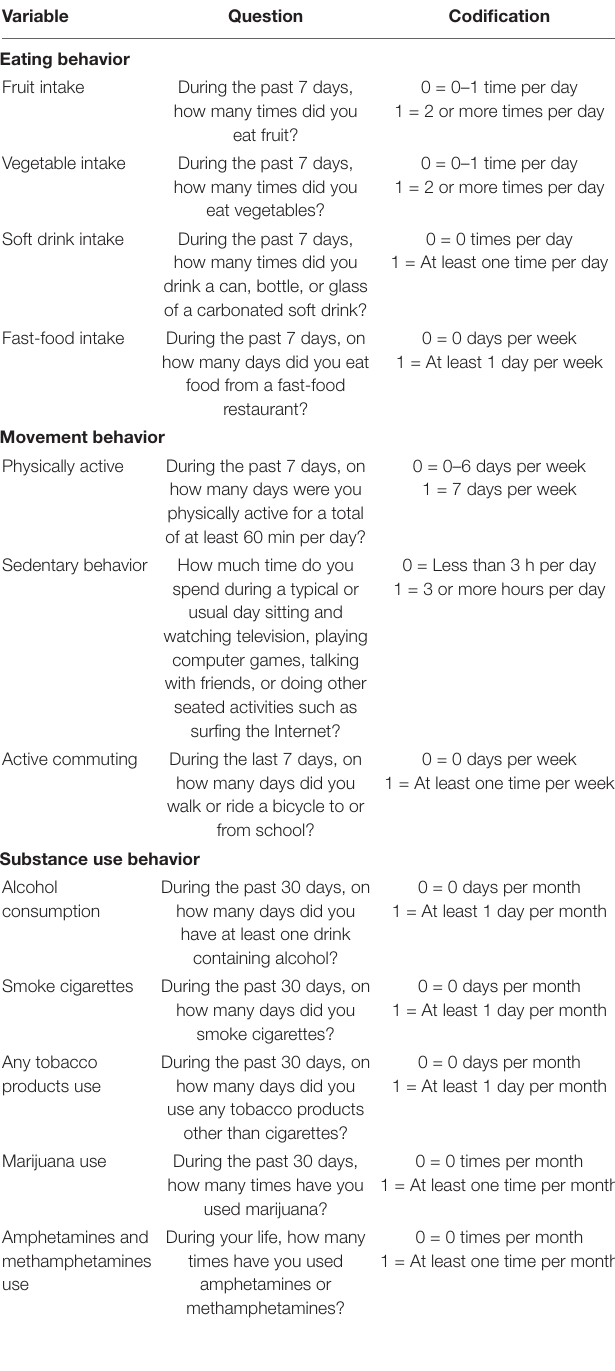
TABLE 1 | Global School-based Health Survey questions included in the analysis of lifestyle correlates related to anxiety-induced sleep disturbance.